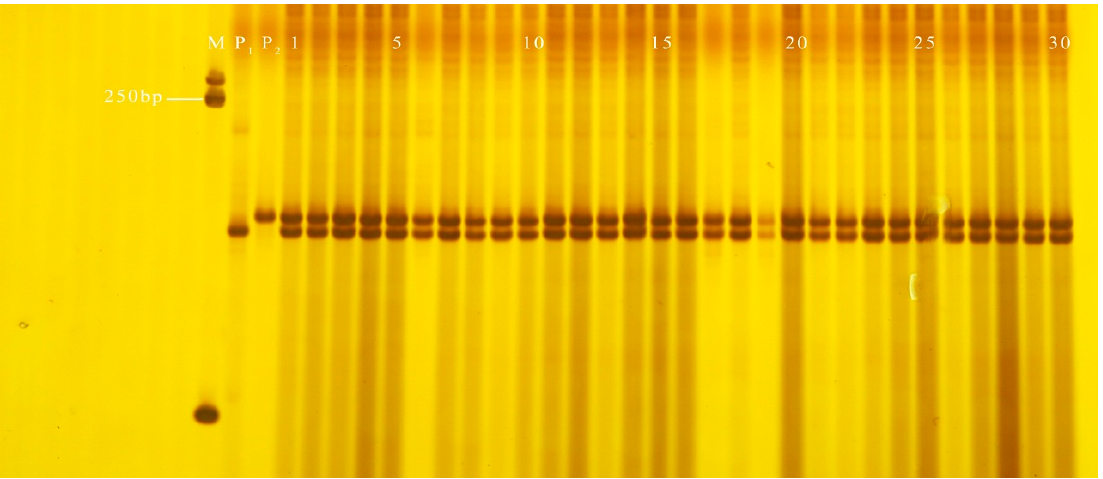
Figure 11. Purity identification of some plants of ‘Chunfeng 818 ′ wax gourd by PS13. M: DL2000 DNA Marker; P 1 : GK-3-4-3-2-1-3 (green peel); P 2 : T-1-1-1 (white peel); 1–30: ‘Chunfeng 818 ′ wax gourd.